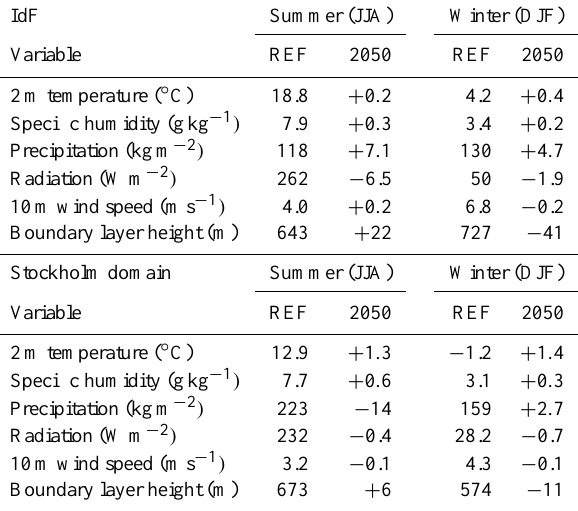
Table 3. Future changes in key meteorological variables in the study regions under the RCP-4.5 climate scenario. Seasonal averages in- clude both daytime and nighttime